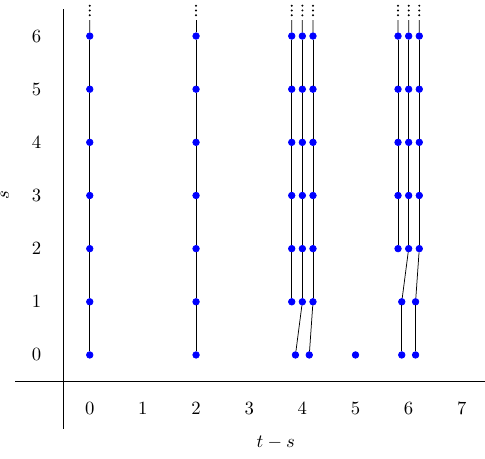
-module structure for (cid:90) / 2 [ w (cid:48) A 1